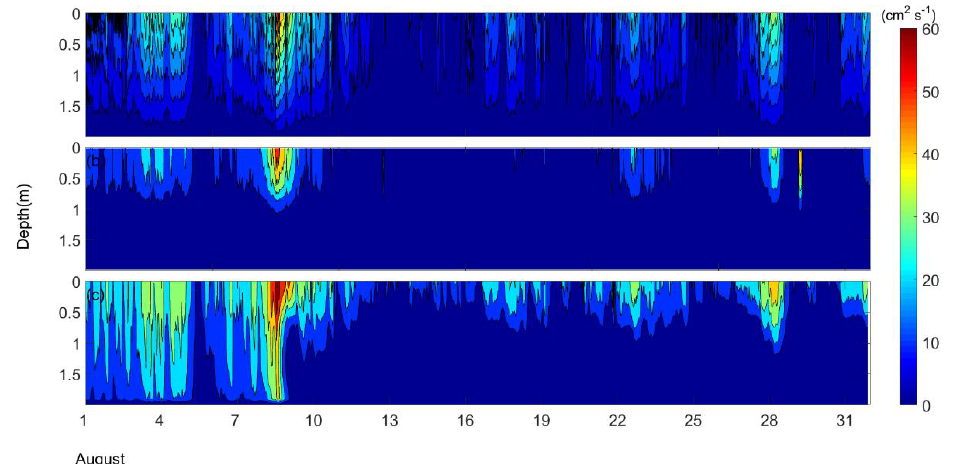
Figure 6. Vertical variations of eddy diffusivity coefficients of lake models ( a ) CLM4-LISSS, ( b ) E- ε ( c ) LAKE.